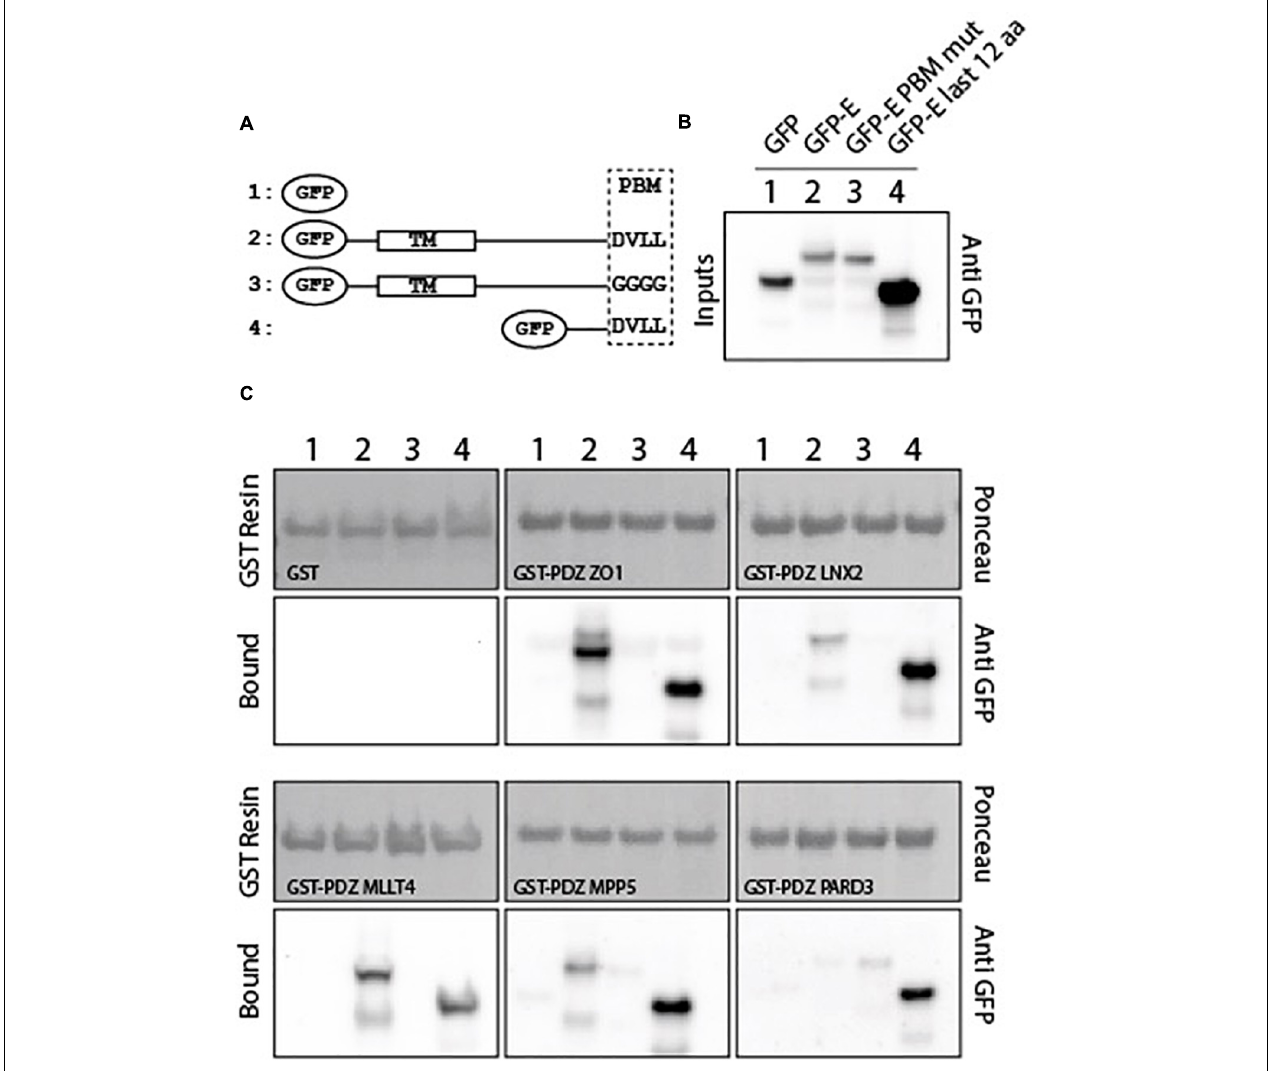
FIGURE 2 | PDZ domains interact with the SARS-CoV-2 full-length E protein in a PBM-dependent manner. (A) Schematic representation of the GFP-E constructs used in this study. Construct 1 corresponds to the GFP alone, construct 2 and 3 to the full-length WT and mutated E protein respectively, and construct 4 to the last 12 C-terminal residues of E protein. TM and PBM correspond to the transmembrane domain and to the PDZ-binding motif, respectively. (B) Input fraction of GFP-tagged viral E gene construct expressed in HEK293 cells and used for pull-down assay. Samples were analyzed by immunoblotting using anti-GFP antibody. (C) Gluthatione S-transferase (GST) pull-down binding results with immobilized GST or GST-PDZ domains (GST-PDZ ZO1, GST-PDZ LNX2, GST-PDZ MLLT4, GST-PDZ MPP5, and GST-PDZ PARD3) used as affinity resin and incubated with the HEK293 cell lysates. GST-tagged proteins were stained by Ponceau S (top panels). The bound fraction was analyzed by immunoblotting using an anti-GFP antibody (bottom panels). Note that blots represent discontinuous panels from the gels when black line delimitation is present. The images have been cropped to frame the relevant